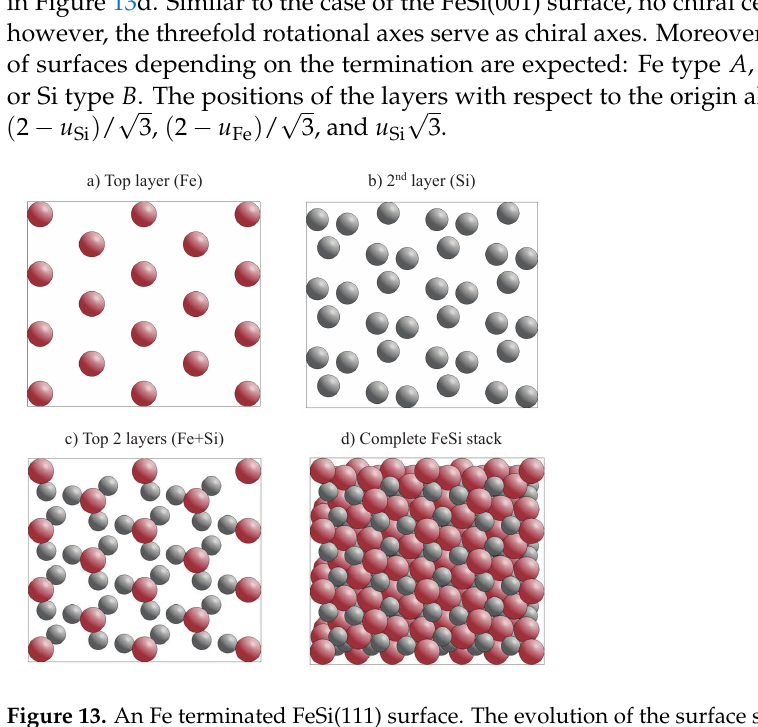
Figure 13. An Fe terminated FeSi(111) surface. The evolution of the surface structure and symmetry are shown for increasing number of layers in ( a – d ), assuming that the surface is terminated by Fe with layer type A (see text).